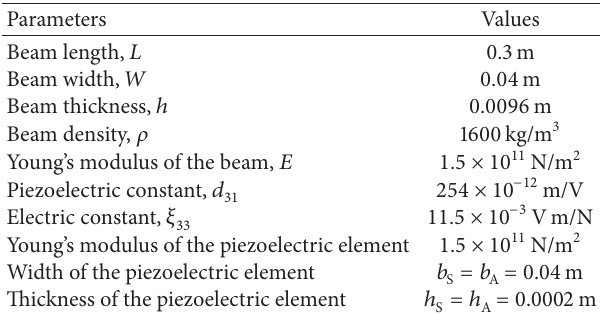
Table 1: Parameters of the composite